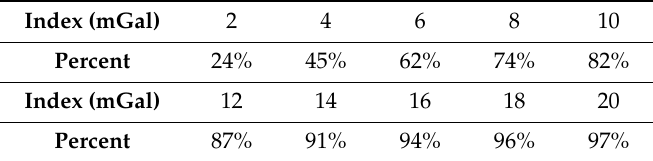
Figure 15. Error compared to SIO gravity anomalies: ( a ) Absolute values of mean error; ( b ) error STD. Table 4. Statistics about the magnitude of gravity anomaly